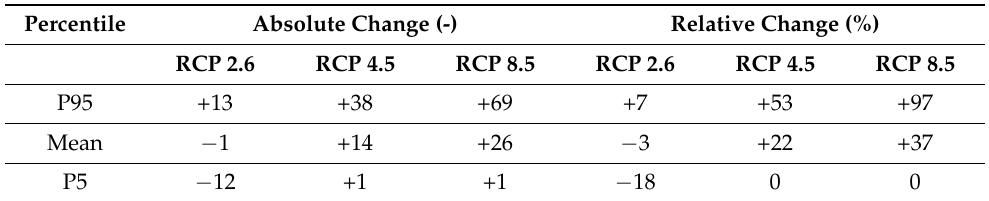
Table 6. Statistics on the absolute change in the yearly mean WD for RCPs 2.6, 4.5 and 8.5 and SW orientation.